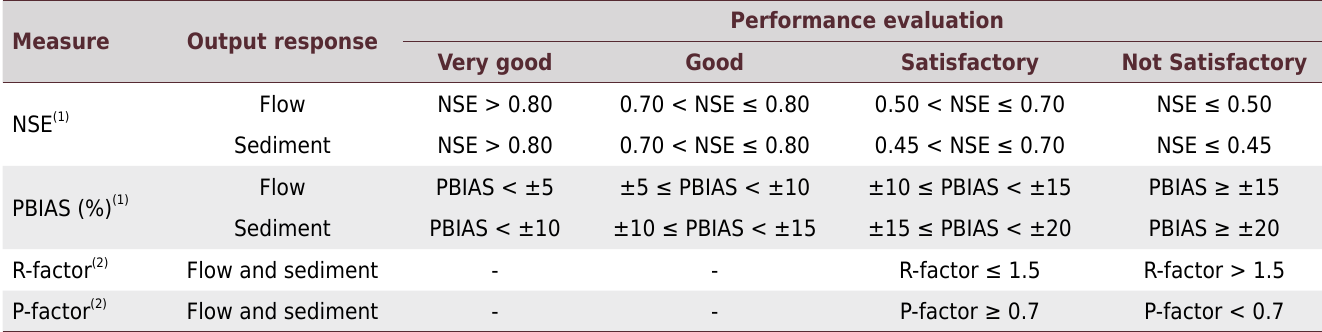
Table 1. Performance evaluation and uncertainty analysis criteria used to classify SWAT model results Measure